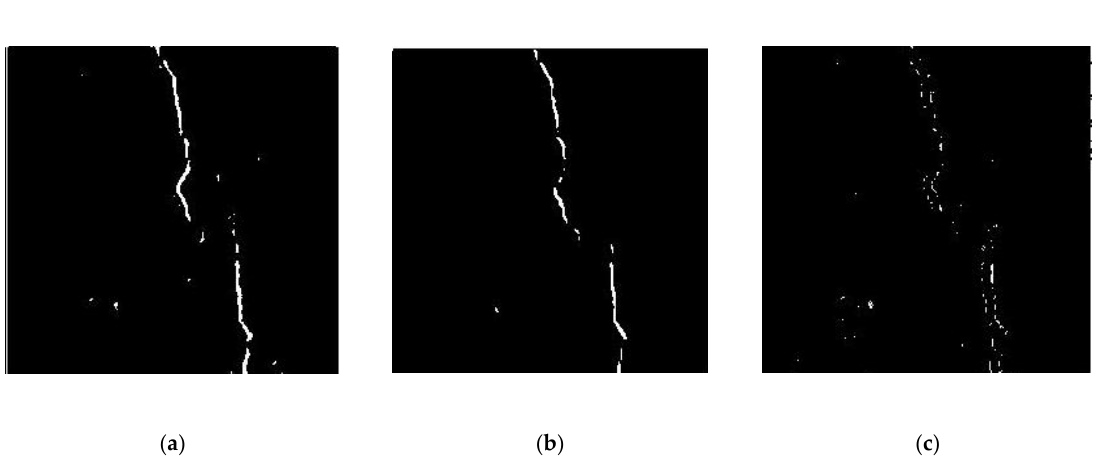
Figure 4. Performance of edge detection operators on rammed earth images. ( a ) Sobel, ( b ) Prewitt and ( c ) Laplacian of Gaussian.